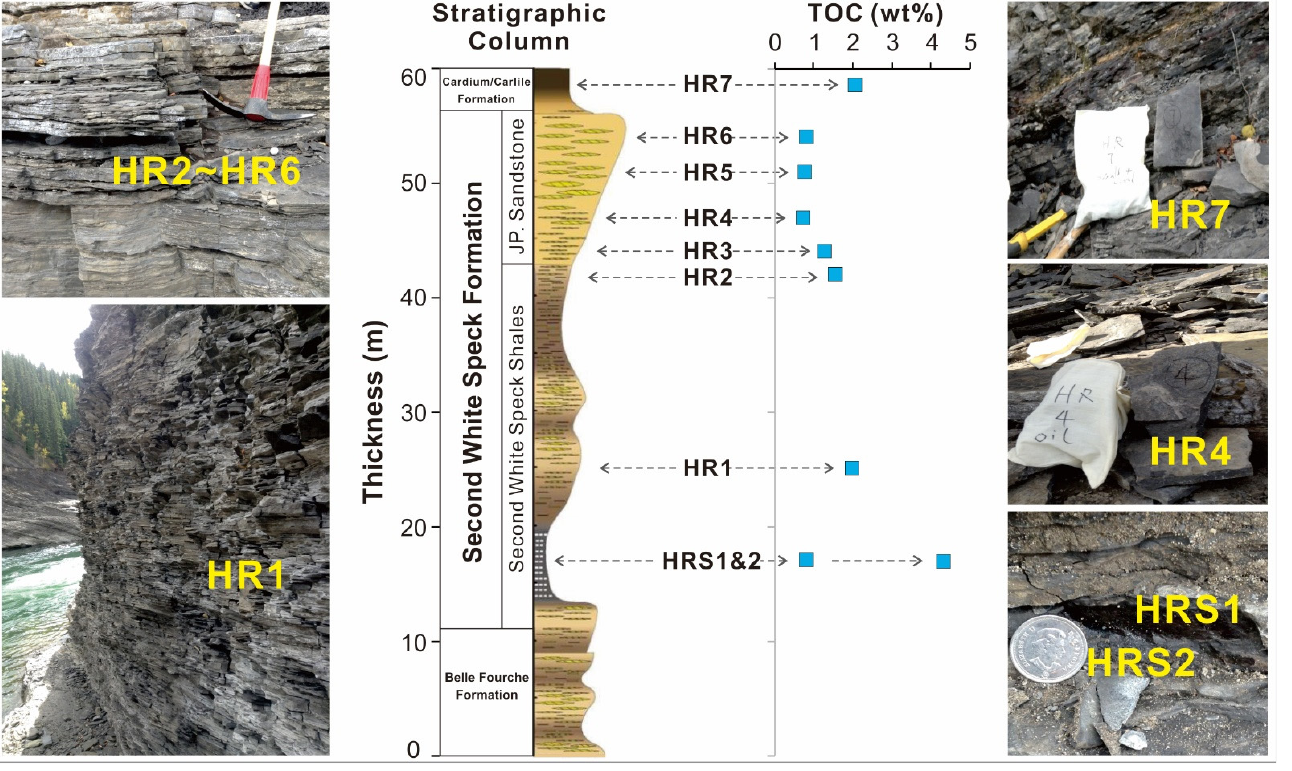
Figure 2. Stratigraphic column of the 2WS along Highwood River outcrop at southwestern Alberta (modified from Komaromi and Pedersen, 2014 [43]), sample location and photograph, together with measured total organic carbon content.